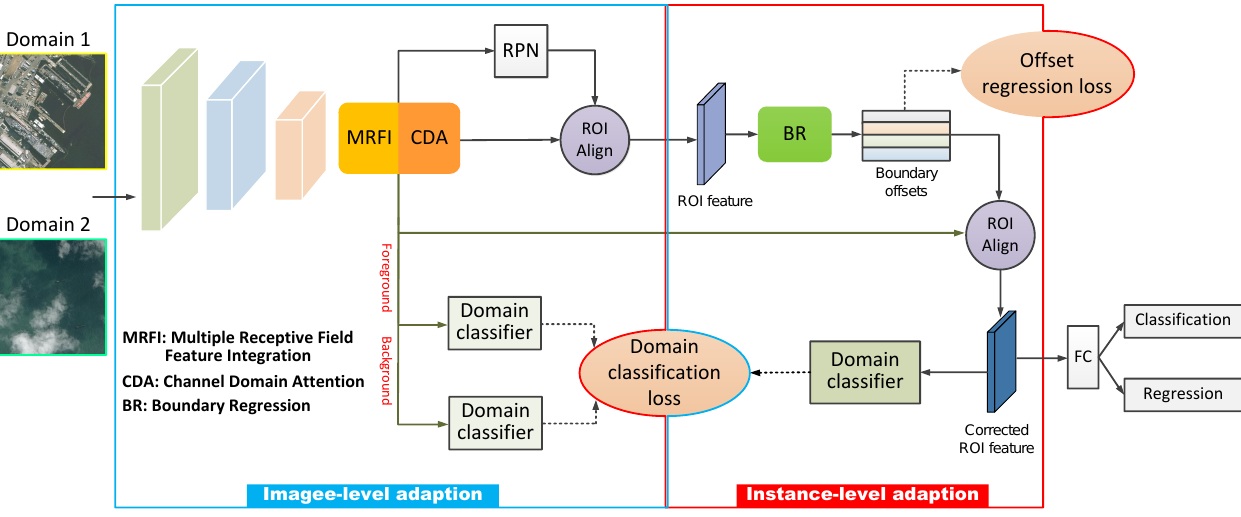
Figure 1. The pipeline of the proposed